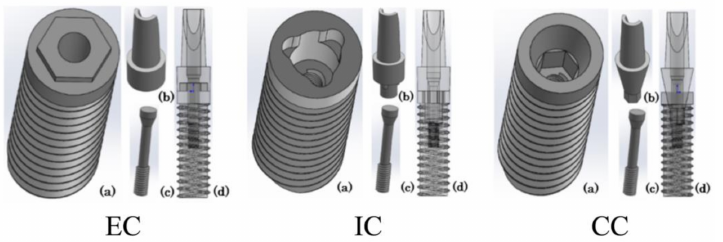
Figure 1. Three-dimensional computer-aided design models. ( a ) Implant body. ( b ) Abutment. ( c ) Abutment screw. ( d ) Model combining ( a – c ). EC: external connection; IC: internal connection; CC: conical connection.